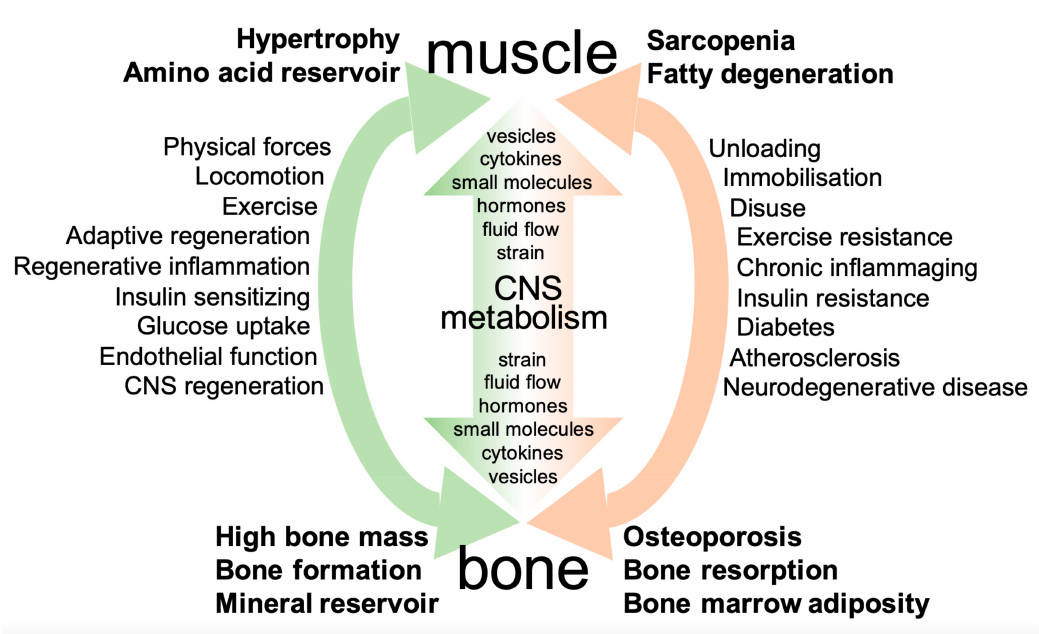
Figure 1. Schematic overview of the interaction between muscle and bone in physiology and pathology, addressing also the most important e ff ectors of interaction. The green color represents the physiological interactions indicating that muscle hypertrophy and high bone mass have interdependent relationships, while the red color shows similarly strong mutual interaction between the loss of bone and muscle due to the intrinsic pathology in degenerative disease such as osteoporosis and sarcopenia, but also lifestyle, disuse, and underlying metabolic diseases such as chronic inflammatory conditions and diabetes